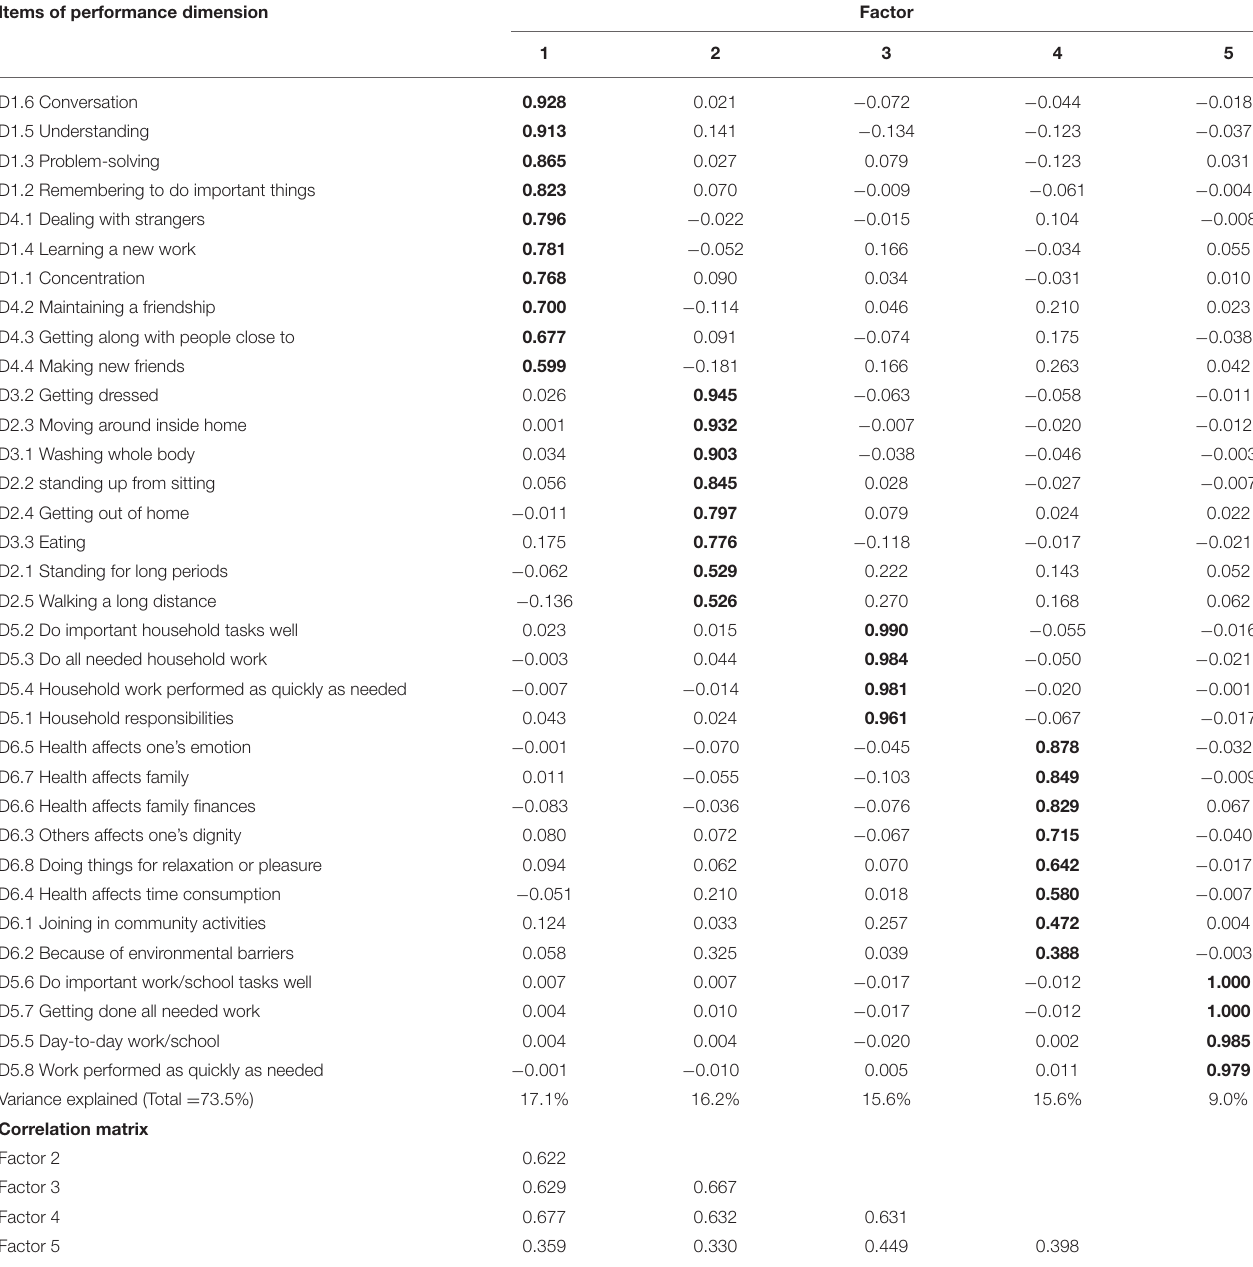
TABLE 2 | Factor loading of the performance dimension of the FUNDES-Adult by exploratory factor analysis ( n = 8730). Items of performance